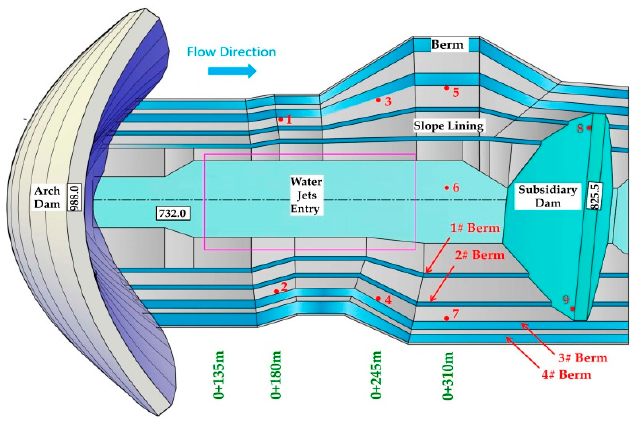
Figure 12. Arrangement of the wave height measuring points.